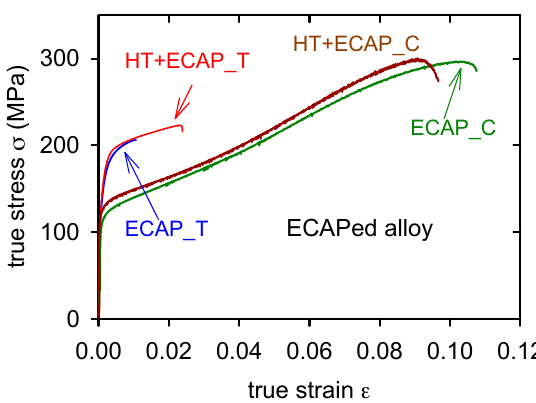
Figure 9. True stress–true strain curves obtained for ECAPed alloy and HT + ECAPed alloy in tension (T) and compression (C).